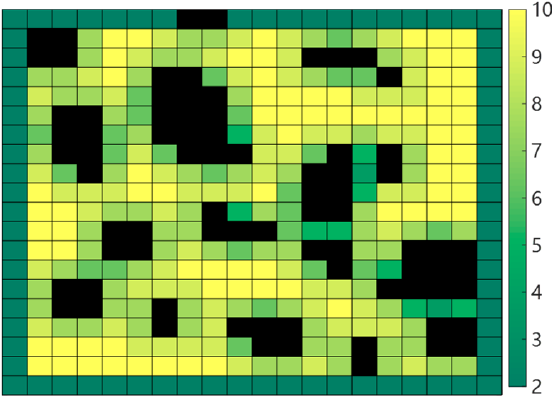
Figure 3. Diagram of initial pheromone allocation.